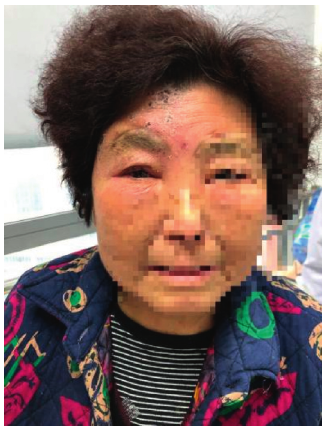
Figure 3: State of the right upper eyelid one week after discharge from hospital (28 days after the onset of rash).